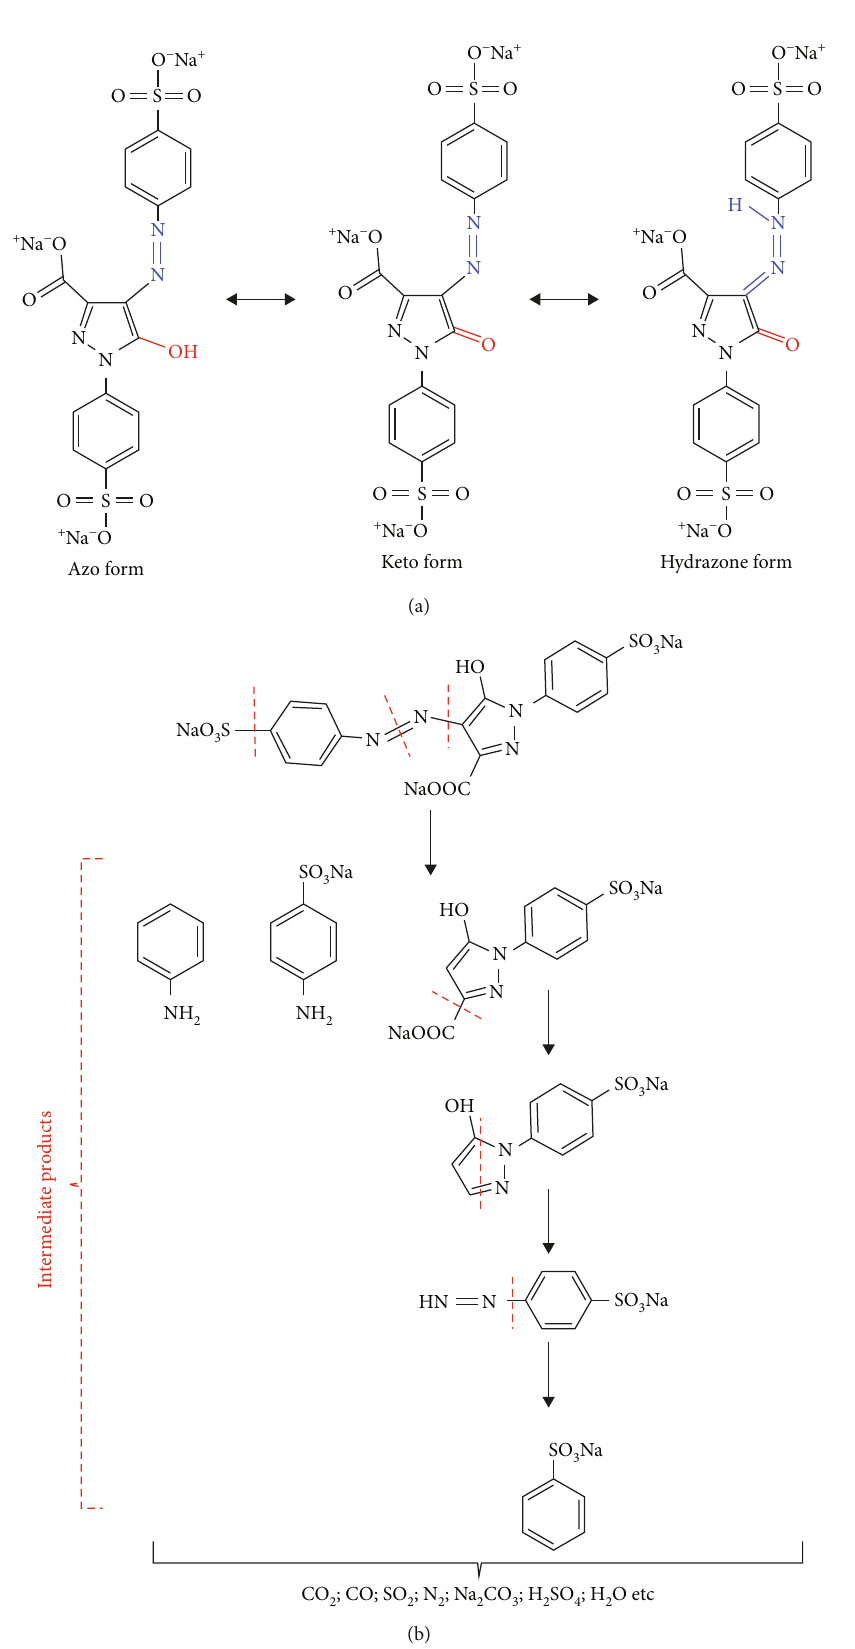
Figure 17: (a) The tautomeric forms of tartrazine and (b) possible route to the destruction of tartrazine in as-synthesized Au/ZnO